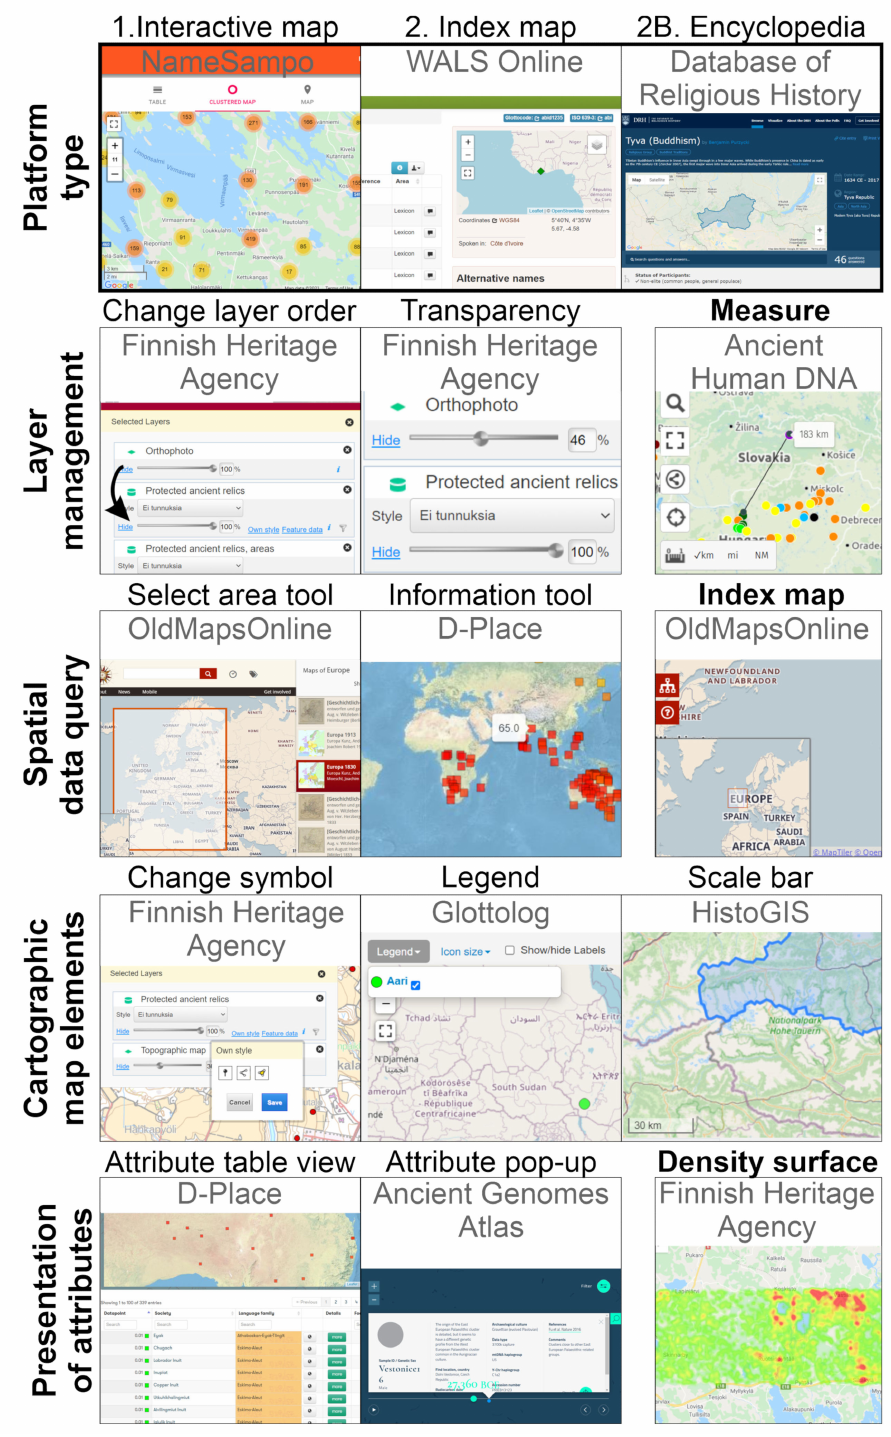
Figure 2. Visualizationof the main platform types and the key functionalities of the reviewed spatial data platforms (see Table